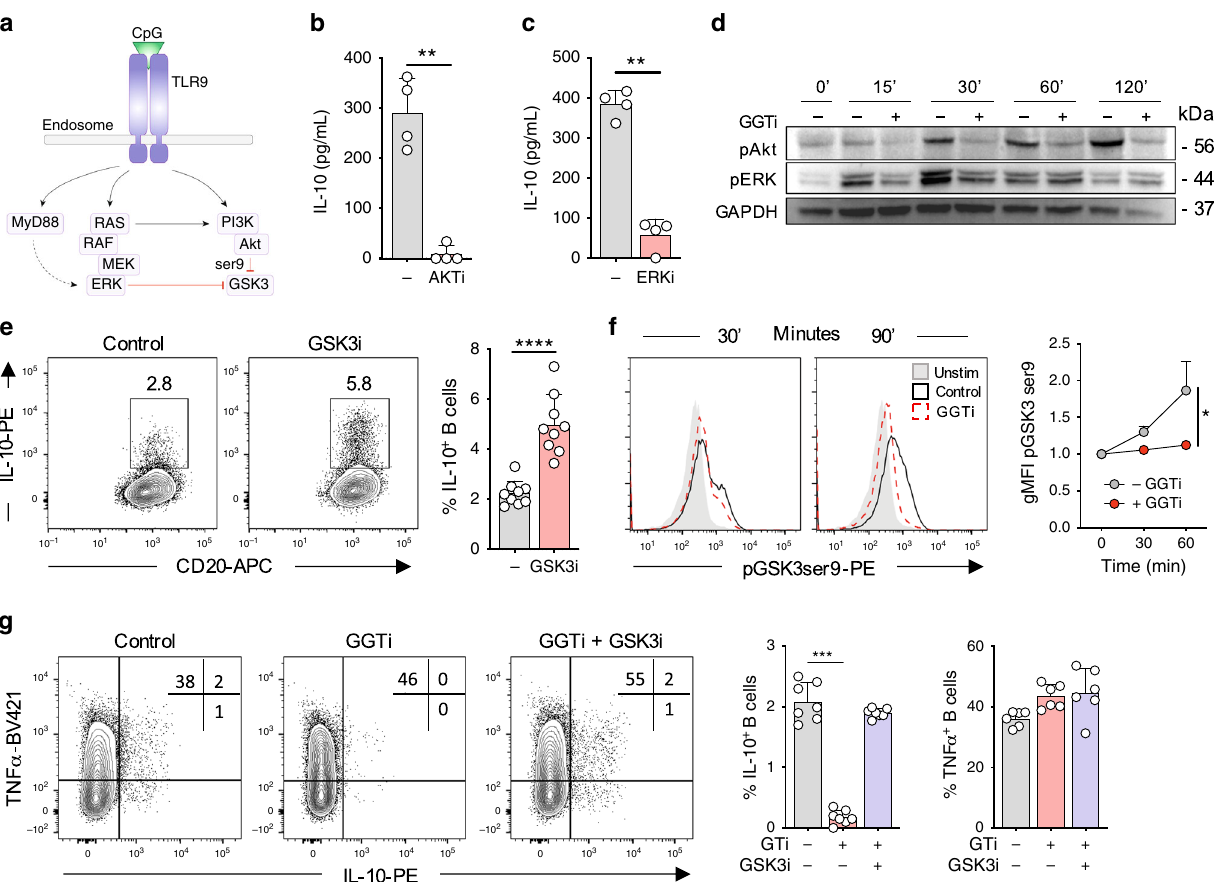
Fig. 3 GGPP regulates signaling through TLR9. a Schematic of Ras-dependent signaling cascades downstream of TLR9. b , c IL-10 expression in human B cells stimulated through TLR9 ± inhibition of ( b ) AKT (AKTi, MK-2206) or ( c ) ERK (ERKi, SCH772984) ( n = 4, pval = 0.005, and 0.001). d Phosphorylation of AKT (ser473) or ERK1/2 (Thr202/Tyr204) over time in human B cells upon stimulation through TLR9± inhibition of geranylgeranyl transferase (GGTi) (representative of n = 3). e IL-10 expression in human B cells stimulated through TLR9± inhibition of GSK3 (GSK3i, CHIR-99021) ( n = 9, pval < 0.001). f Phosphorylation of GSK3 (ser9) over time in human B cells upon stimulation through TLR9± inhibition of geranylgeranyl transferase (GGTi-298), relative to unstimulated controls ( n = 4, pval = 0.02). g IL-10 and TNF expression in human B cells stimulation through TLR9 ± GGTi ± GSK3i ( n = 7, pval = 0.0001). Each data point represents individual donors. All data presented are mean ± SD. Statistical testing in fi gures in ( b ), ( c ), and ( e ) was done by a paired t test, f using a twoway ANOVA with Sidak ’ s multiple comparisons test, and g by Friedman ’ s test with Dunns ’ s multiple comparisons test ** P < 0.01, *** P < 0.001, **** P < 0.0001 and all signi fi cant values are